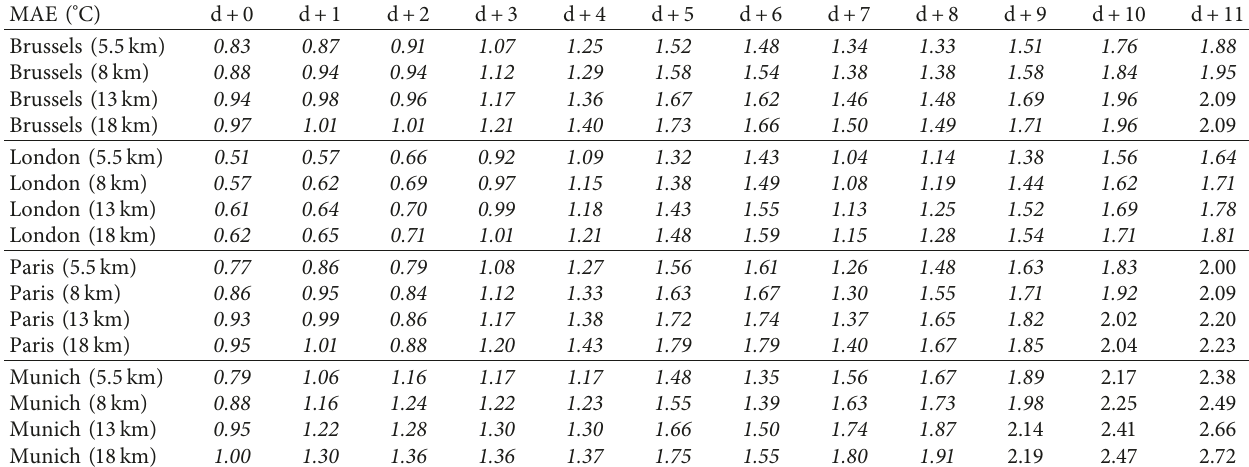
Table 2: MAE of the e-kmf ™ temperature forecasts at different spatial resolutions and lead times over the European cities; values in italics depict a forecast below the 2 ° C error